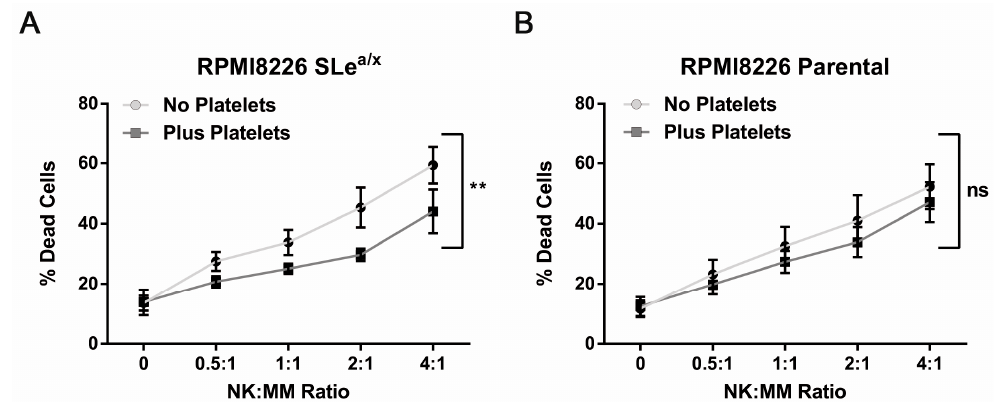
Figure 4. Platelet binding decreases NK-mediated cytotoxicity in sensitive SLe a/x -enriched MM cells. SLe a/x -enriched ( A ) and parental ( B ) RPMI8226 cells were incubated with/without platelets at a 500:1 platelet:MM ratio as described before. After incubation, cells were washed and incubated for 5 h with platelet-autologous NK cells that have been expanded for 7 days in vitro. NK cells were pre-labeled with the cell trace Carboxyfluorescein succinimidyl ester (CFSE) to distinguish them from MM cells. After 5 h, cell death was assessed by flow cytometry using the Annexin V/7AAD assay. Points on the curves represent the mean ± sem of at least 3 independent experiments. Statistical analysis was performed using the two-way ANOVA and the square commas indicate the comparisons between the two curves. ** p < 0.01; ns non-significant.